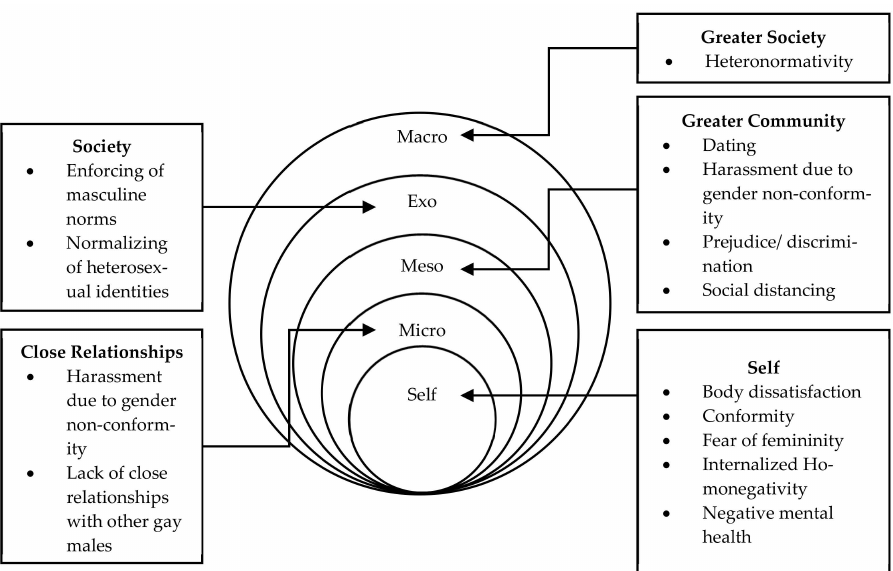
Figure 1. Socio-ecological map of an Australian gay man